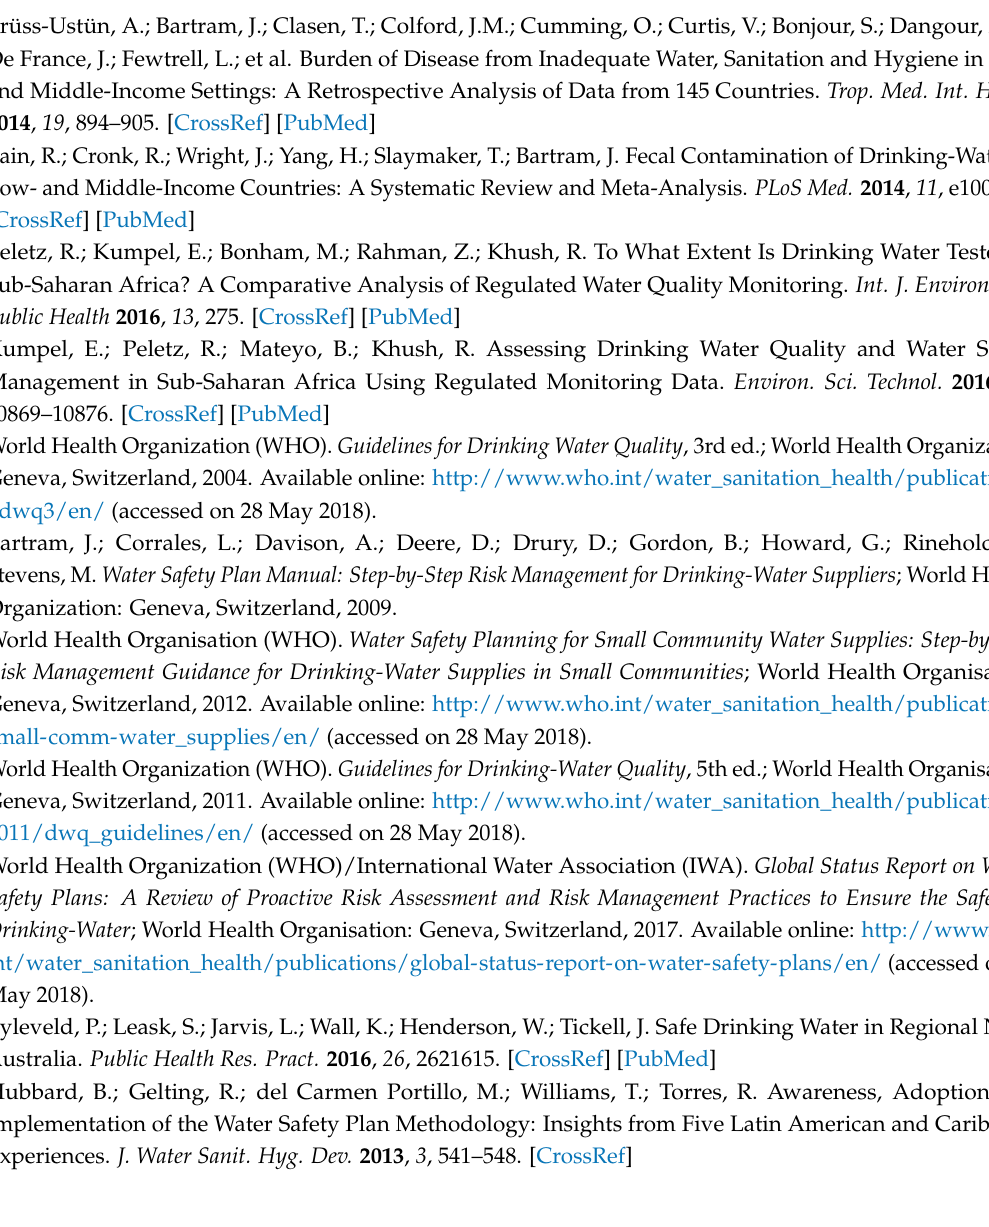
Table S1: Number of sites participating in the impact assessment in each country and criteria used for their selection, Table S2: Description of data collection teams in each country, training processes, dates of baseline and follow-up data collection, and proportion of sites where baseline data were collected retrospectively, Table S3: Comparison of data collectors’ scores with independently assigned scores by Aquaya